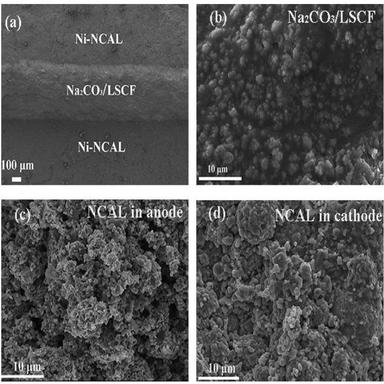
The elemental mapping obtained by EDS of cross-sectional cell: (a) electron image, (b) La, (c) Fe, (d) Sr, (e) Na, (f) Ni, (g) Co,(h) Al and (i) O element.